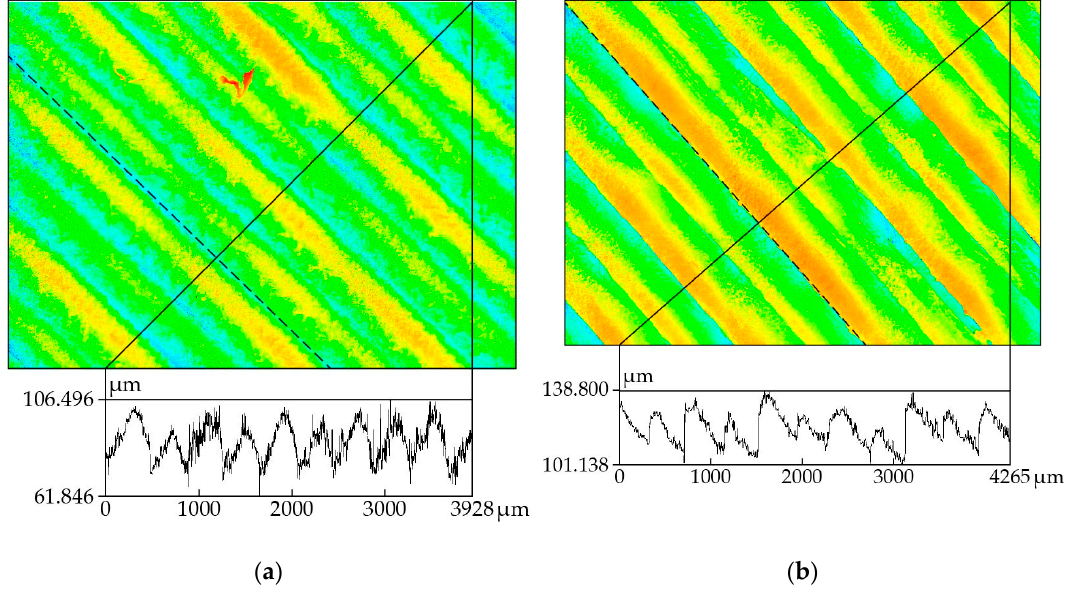
Figure 13. Height images of regular PLA specimens ( a ) and smoothened PLA specimens ( b ).